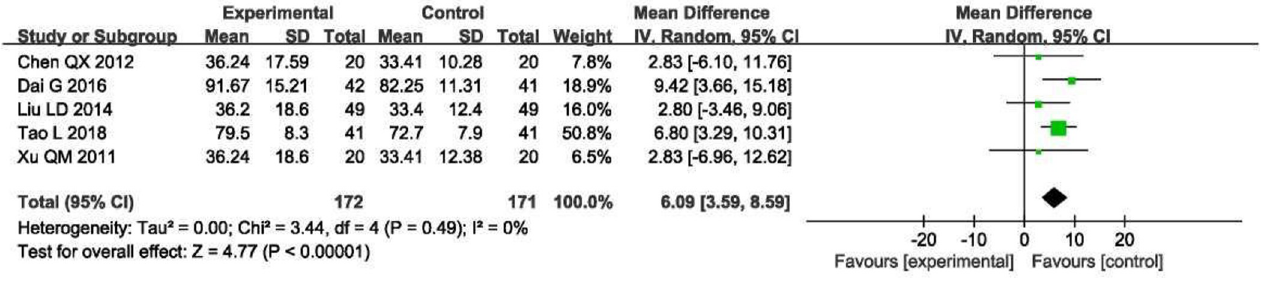
Common clinical adverse reactions to alprostadil included pain in the blood vessels at the injection site, phlebitis, flushing of the face, dizziness, palpitations, nausea, and pruritus. Of the 20 clinical trials, five trials (429 patients) reported no adverse reactions, and seven trials (502 patients) clearly demonstrated high safety and no adverse reactions. In the other eight studies (510 patients), 18 patients in the experimental group experienced vascular pain at the injection site, three experienced dizziness and headache, and two experienced nausea; while in the control group there was one case each of facial flushing, headache, vomiting, diarrhea, and palpitations. These adverse reactions were well tolerated by the patients, and no serious adverse reactions were observed. The symptoms disappeared after slowing down the adminis- tration rate or relieved spontaneously without special treatment; therefore, no patients were terminated or withdrawn from the trials.